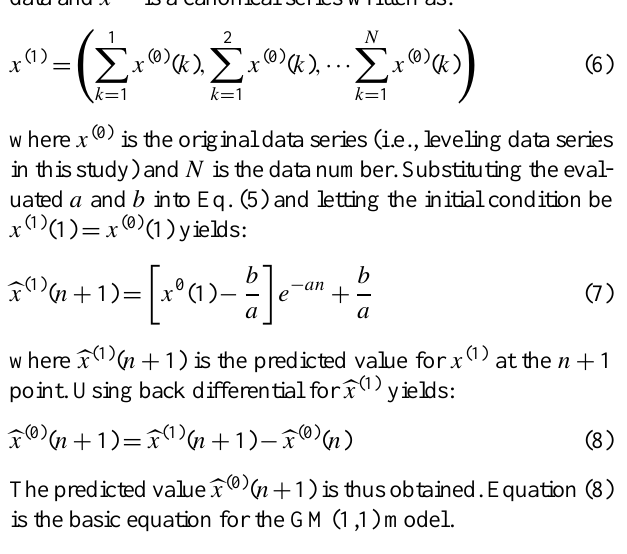
λ and µ are Lame’s constants ( µ = E/ 2(1 + ν ), and λ = Eν/ (1 + ν )(1 − 2 ν ), where E is Young’s modulus, and ν